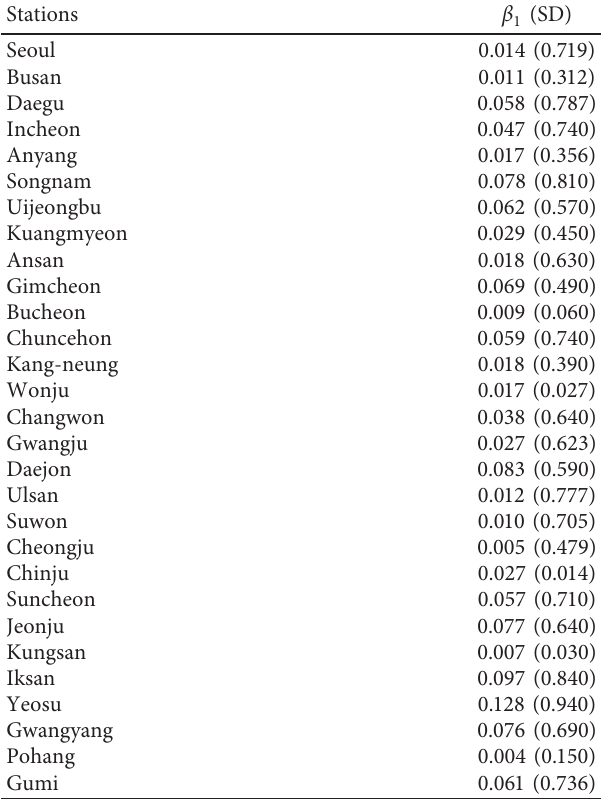
Table 1: The slope ( β 1 ) and its standard deviation (SD) of the trend line fitted for Bayesian extreme value analysis at 5% level of sig- nificance in all 29 air monitoring